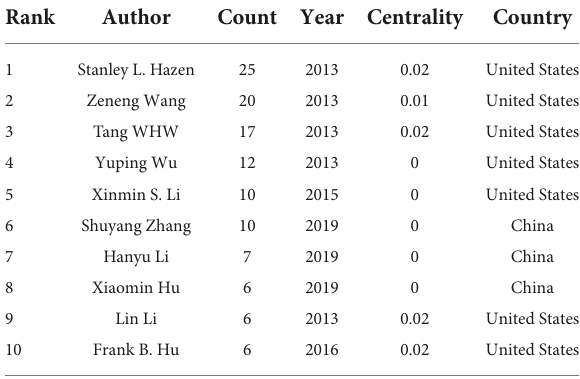
TABLE 1 Top 10 authors on CHD and gut